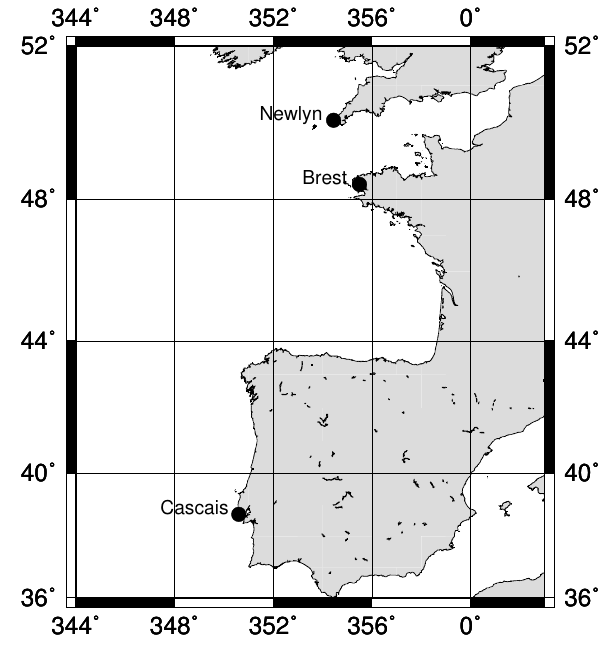
Fig. 1. Study area with tide gauge